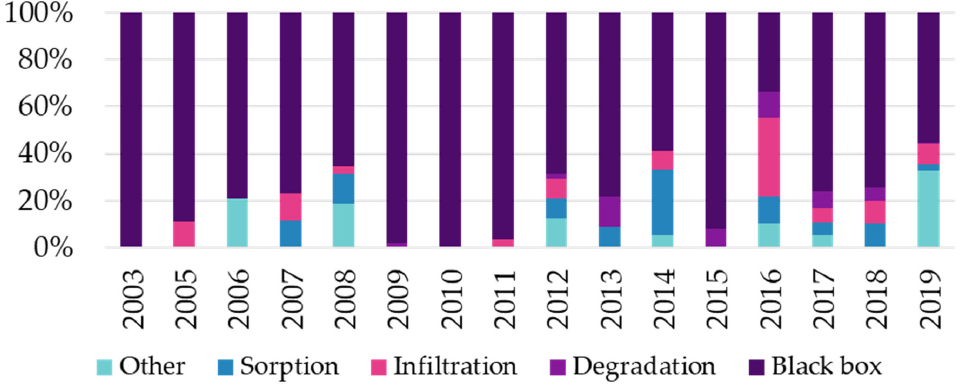
Figure 10. Breakdown of contaminant transport and fate studies by reduction pathway.